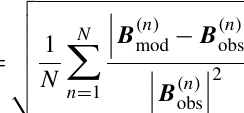
Figure 2. Juno perijove 1 trajectory in JSM Cartesian coordinates plotted versus time in DOY 2016, where the vertical dashed line shows the time of